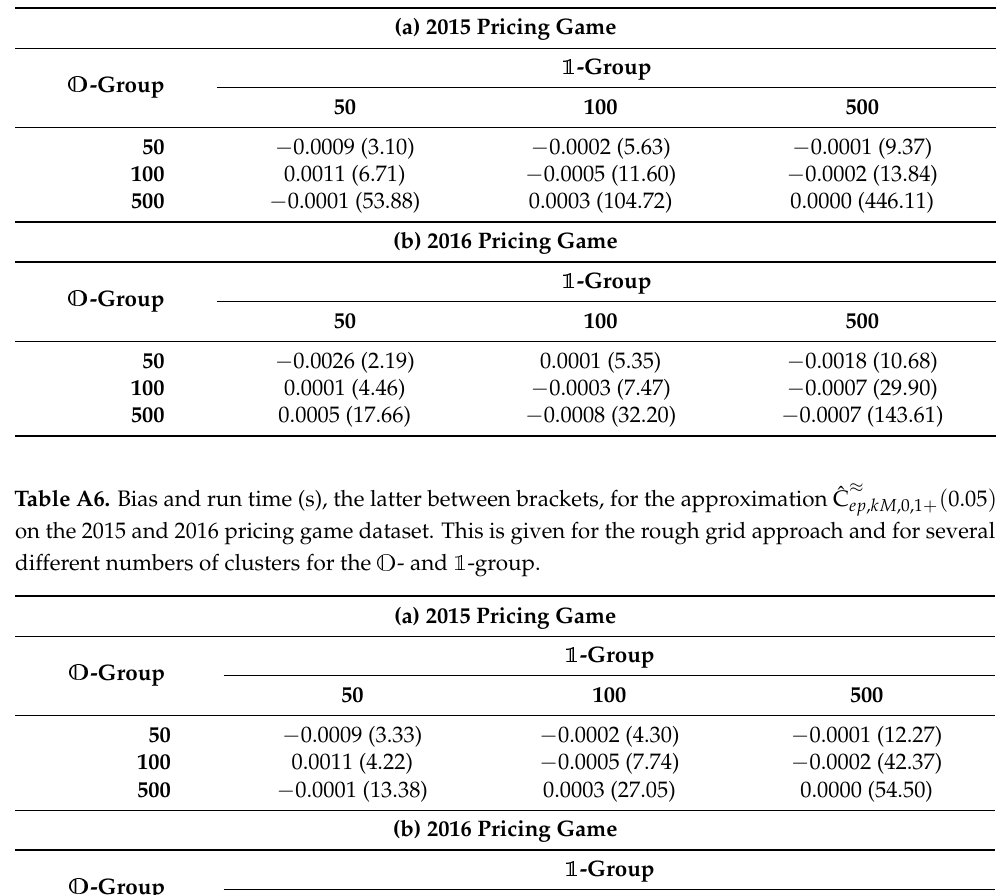
Table A5. Bias and run time (s), the latter between brackets, for the approximation ˆC on the 2015 and 2016 pricing game dataset. This is given for the fine grid approach and for several different numbers of clusters for the O - and 1 -group.